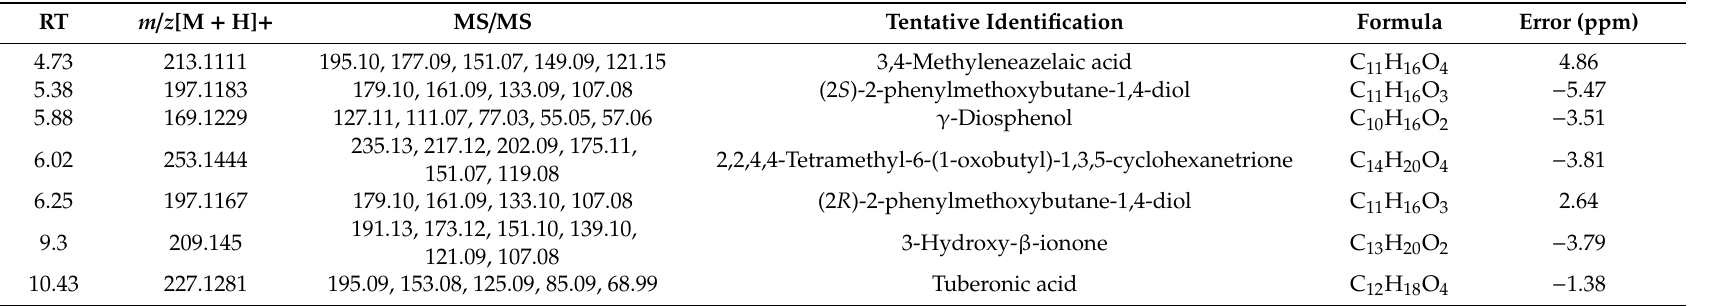
Table 1. MS data of ( + ) ESI-QTOF-MS of MO subfraction and tentative